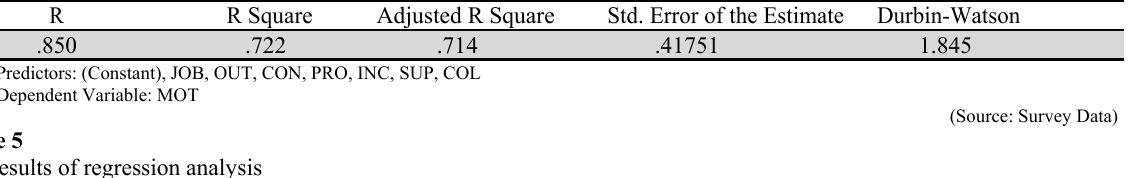
The examination of the explanatory level of the model (Model Summary b ) R R Square Adjusted R Square Std. Error of the Estimate